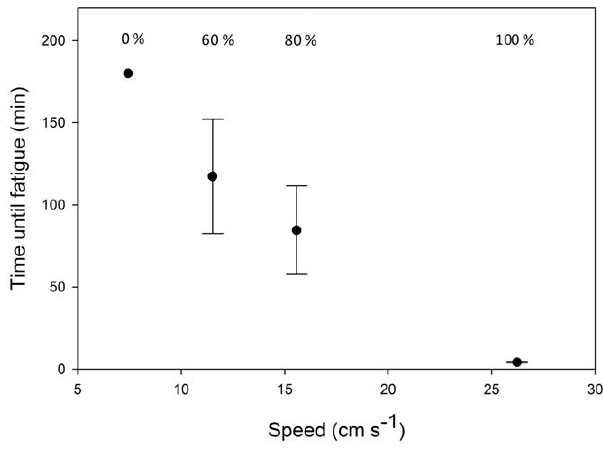
Figure 3. Time taken to fatigue (mean ± SE) for S.apama. Five individuals were swum at each speed, and the percentage of individuals that fatigued within 180 min of swimming is indicated.